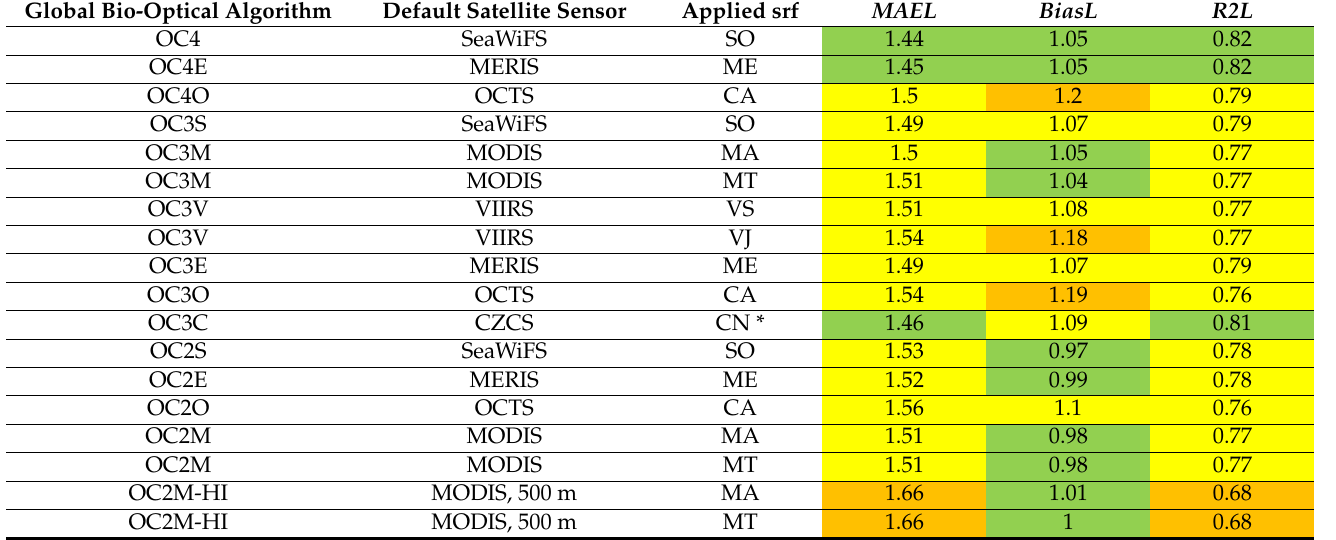
Table 8. Quality of applying the global bio-optical algorithms presented at https://oceancolor.gsfc. nasa.gov/atbd/chlor_a/ (accessed on 15 November 2022) to an estimation of chl-a concentration from shipboard remote sensed hyperspectral data by applying the corresponding spectral response function (srf). Statistical metrics were calculated by the comparison of in situ chl-a measurements ( C ins ) and remote sensed estimations C rs . The best results are highlighted in green, mediocre in yellow, and worst in